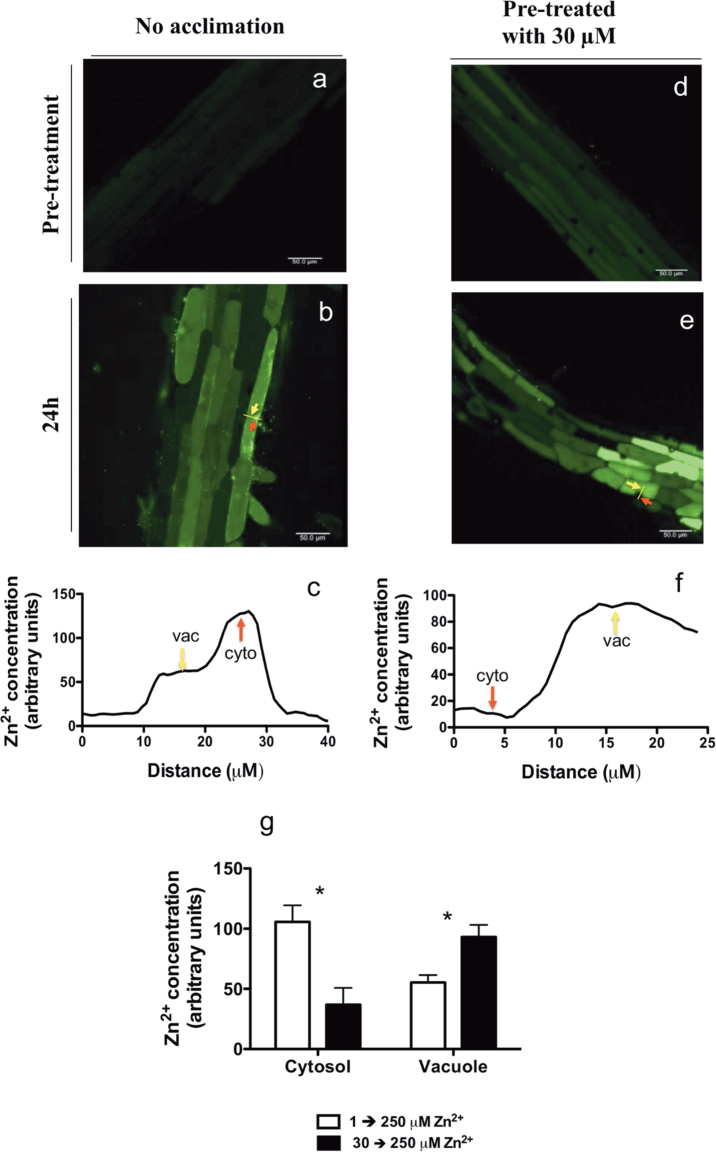
Zinc compartmentation in root epidermal cells of tobacco plants before (a, d) and after (b,e) the addition of ZnSO4 (with a final concentration of 250 μM ZnSO4 in the medium) in non-acclimated (a, b) and acclimated (d, e) plants. One typical root for non-acclimated (c) and non-acclimated (f) plants is shown. Measurements were made in the mature zone, between 10 and 20mm from the root apex. In (g), quantification of the cytosolic:vacuolar Zn2+ content ratio in epidermal root cells was evaluated and values are given as means±SE (n=12–16). The Zn2+ content in each cell compartment is proportional to the intensity of FluoZin-3-AM (showed in arbitrary units). Asterisks indicate significant differences between acclimated and non-acclimated treatment. *P<0.05.